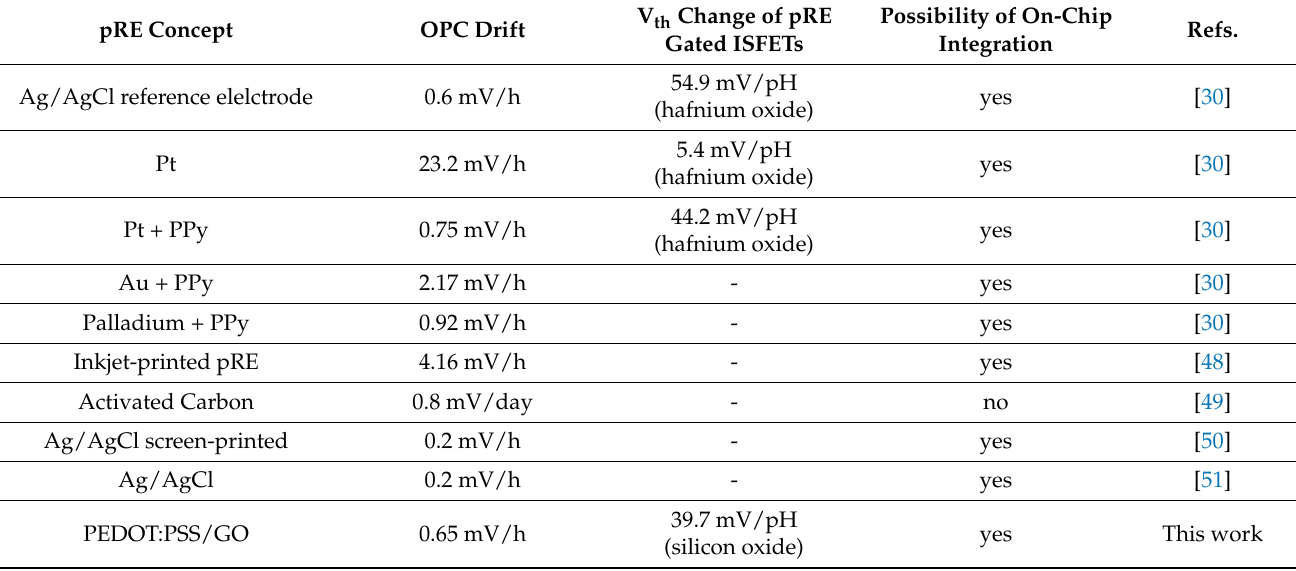
Table 3. Comparison of different pRE approaches in terms of drifting and achieved pH sensitivity of ISFETs gated with